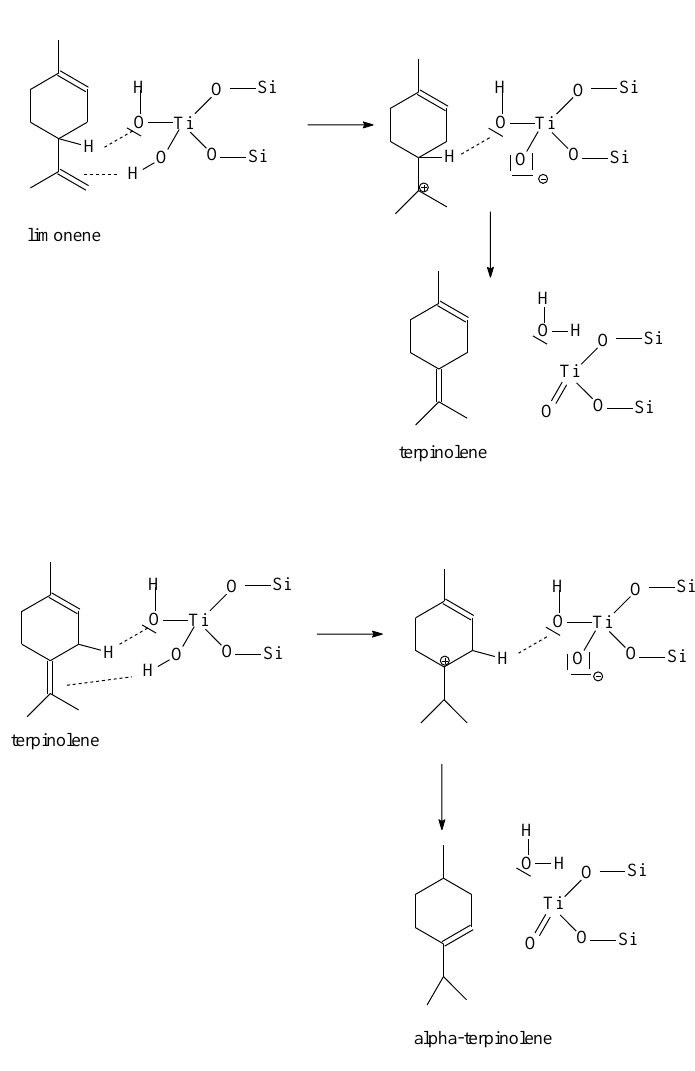
Figure 1. The mechanism of isomerization and dehydrogenation of limonene. Catalysts 2019 , 7 , x FOR PEER REVIEW